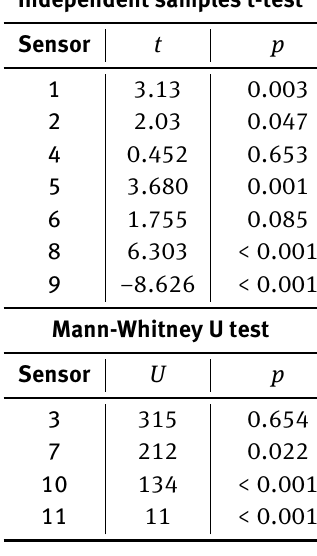
Table 6: Statistical tests used to compare the “best” predefined handshake from Section 4 and the customized handshake from Section 6. Means and variances plotted on Figure